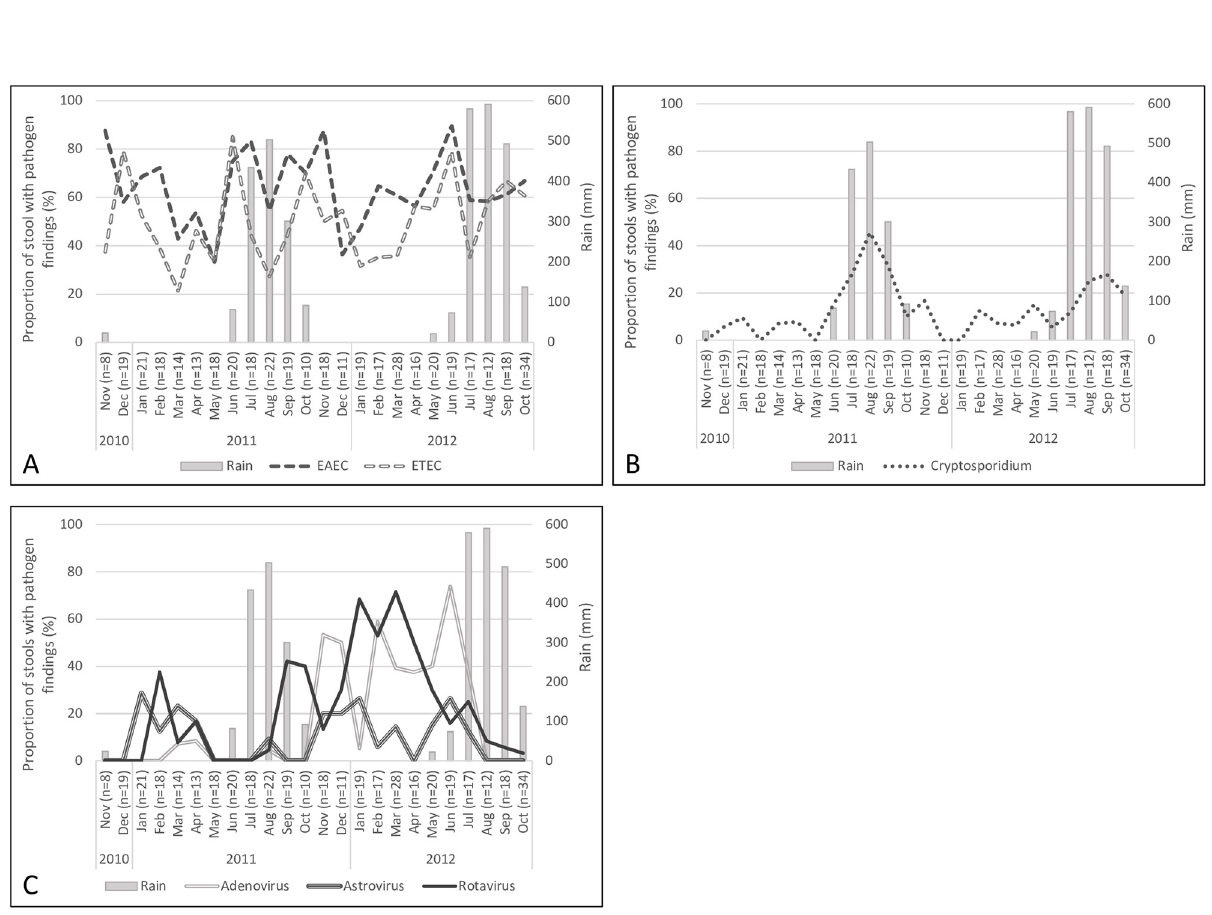
Fig 3. Seasonal variation of diarrhoeal pathogens with respect to rainfall [4]. For the six pathogens showing seasonal variation in incidence, data are shown as monthly proportions of samples positive for A) bacterial (EAEC, ETEC), B) parasitic ( Cryptosporidium) , and C) viral pathogens (adeno-, astro-, and rotavirus). Details of all pathogen findings are shown in S1 Fig. Numbers of children are indicated in parentheses for each month.